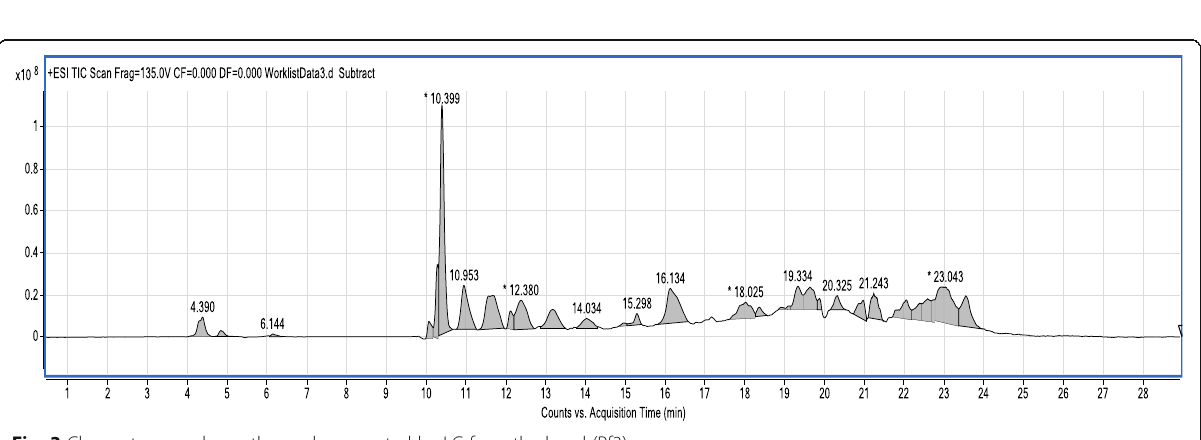
Fig. 3 Chromatogram shows the peaks separated by LC from the band